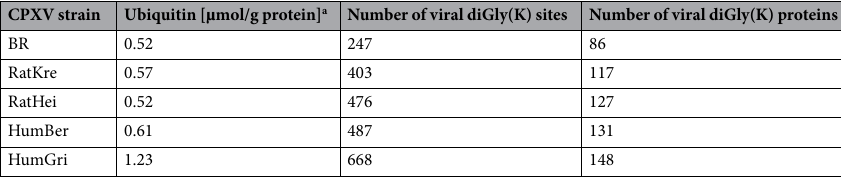
Table 1. Ubiquitin amount, viral ubiquitination sites and associated viral proteins. a Ubiquitin amount in non-diGly(K)-enriched virions calculated by total protein approach (TPA) 61 . By TPA method, protein concentrations can be estimated without spike-in standard, assuming that the spectral intensity is proportional to the protein